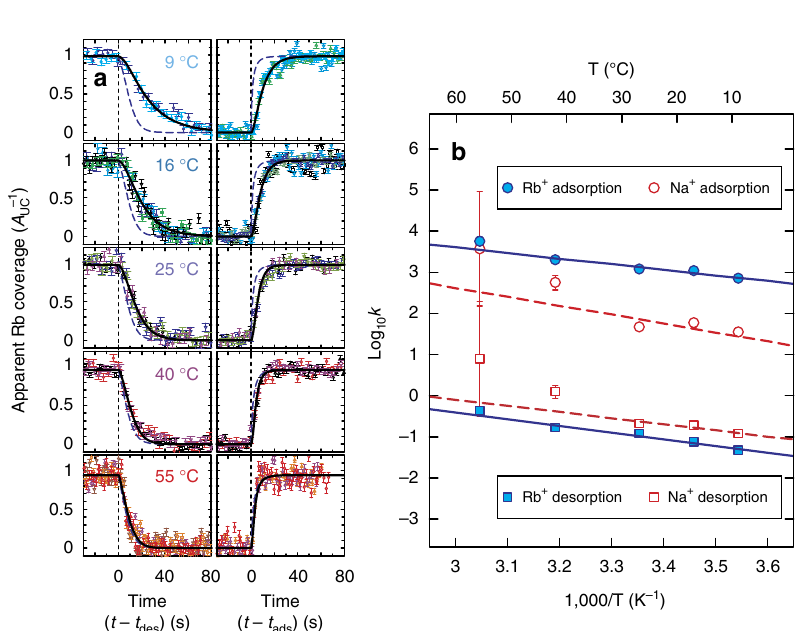
Figure 5 | Exchange kinetics between Rb þ and Na þ adsorbed at the muscovite–water interface as a function of temperature. ( a ) Time-dependent change in apparent Rb þ coverage measured during Rb þ desorption (left) and adsorption (right) at 9, 16, 25, 40 and 55 (cid:2) C. Each symbol with a different colour represents one independent data set. The s.d. error bars were calculated from the counting statistics 43 . Dotted vertical lines show the time when the solution exchange started (either t des or t ads ¼ 0 for Rb þ desorption and adsorption, respectively). The solid lines show the Rb þ coverages calculated from the best-fit models using equations (1 and 2). The long-dashed lines are the equilibrium coverages calculated using the intrinsic adsorption constants 35 and ion activities 44 , and the known solution exchange rates (Supplementary Note 2), and show the limit of the measurements for the fast reaction kinetics at 55 (cid:2) C. ( b ) Arrhenius plot of the measured kinetic rate constants as a function of inverse temperature. The derived constants for Rb þ adsorption (solid circles) and desorption (solid squares) are shown with the best-fit lines (solid lines). The rate constants for Na þ adsorption (open circles) and desorption (open squares) obtained from this model, along with the best-fit trend lines (dashed lines), are shown for comparison.